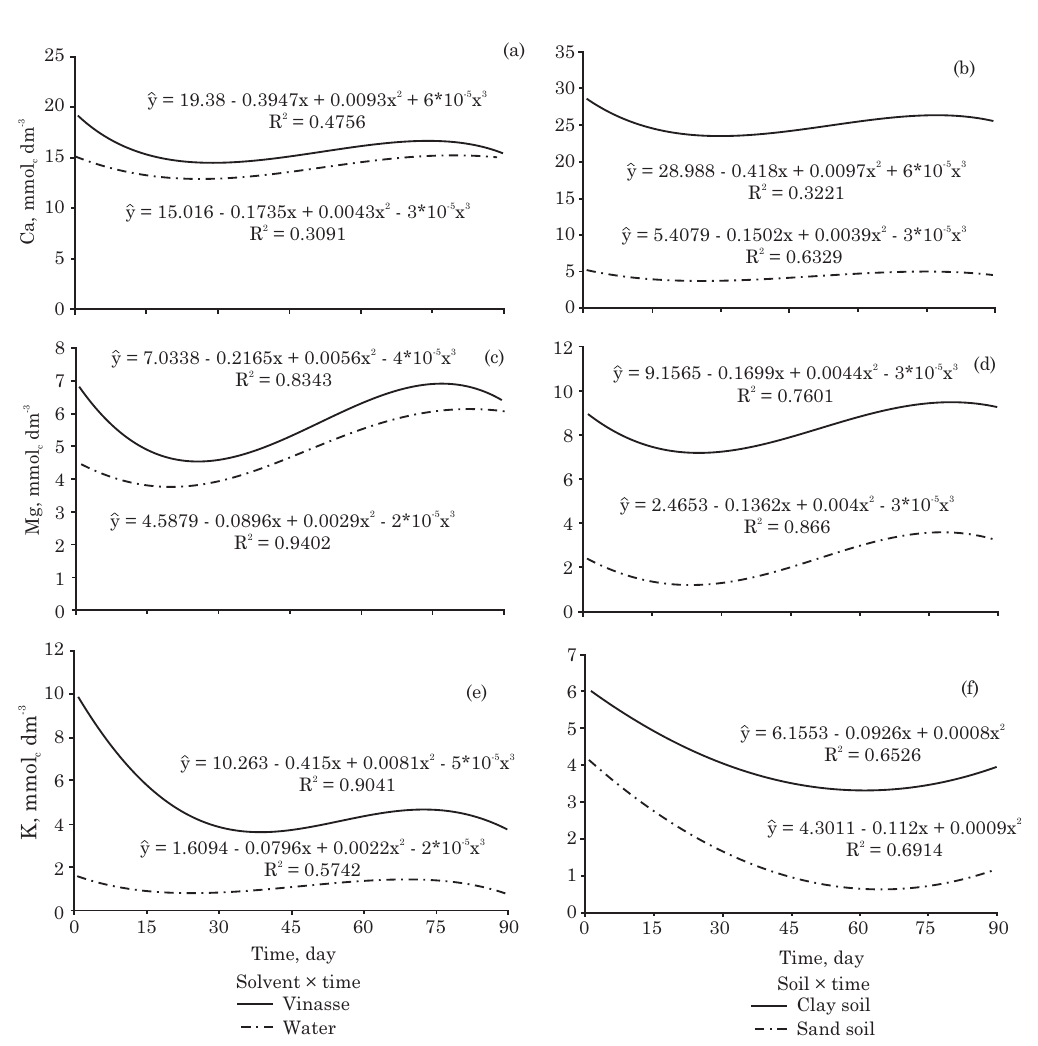
Figure 3. Effect of solvent for Ca (a), Mg (c) and K (e), and soil for Ca (b), Mg (d) and K (f) on the variation in macronutrient levels based on vinasse application and soil type (Red Oxisol - clayey soil, and Typic Quartzipsamment - sandy soil).